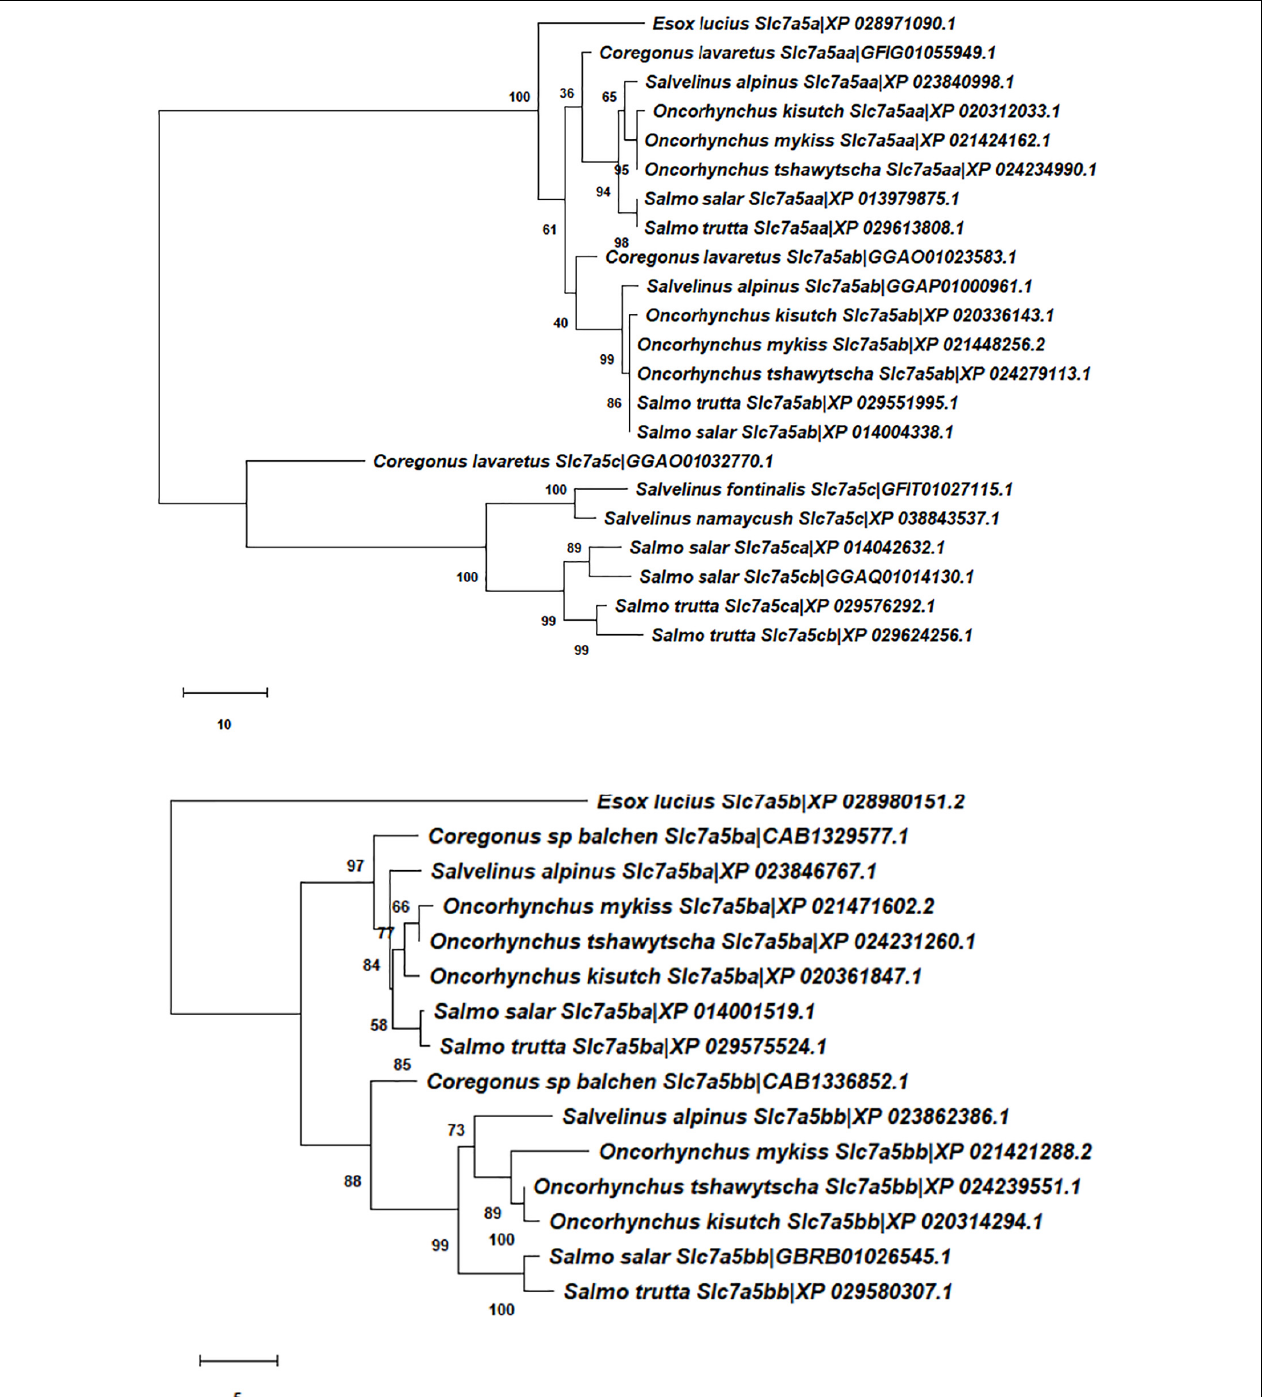
FIGURE 1 | Unrooted phylogenetic trees depicting the evolutionary relationships of Atlantic salmon Slc7a5-type transporters in the context of the evolutionary relationships of Salmoniformes and Esociformes. Multiple protein sequence alignments were obtained by Clustal Omega (https://www.ebi.ac.uk/Tools/msa/clustalo/) using default parameters. The unrooted trees were constructed using the neighbour-joining method (Saitou and Nei, 1987) based on the alignment of the complete amino acid sequences of transporters. Bootstrap values (1000 replicates) indicating the occurrence of nodes are reported above each branch in the figure. The evolutionary distances were computed using the number of differences method (Nei and Kumar, 2000) and are in the units of the number of amino acid differences per sequence. Classical protein GenBank identification (ID) numbers are indicated for the canonically annotated amino acid sequences, while Transcriptome Shotgun Assembly (TSA) IDs are given for those amino acid sequences derived from (a) TSA project(s) by transcript-to-protein sequence translation (via ORFfinder; https://www.ncbi.nlm.nih.gov/orffinder/).